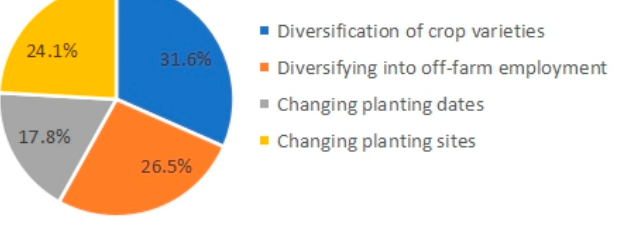
Figure 3. Respondents’ main adaption behaviors.